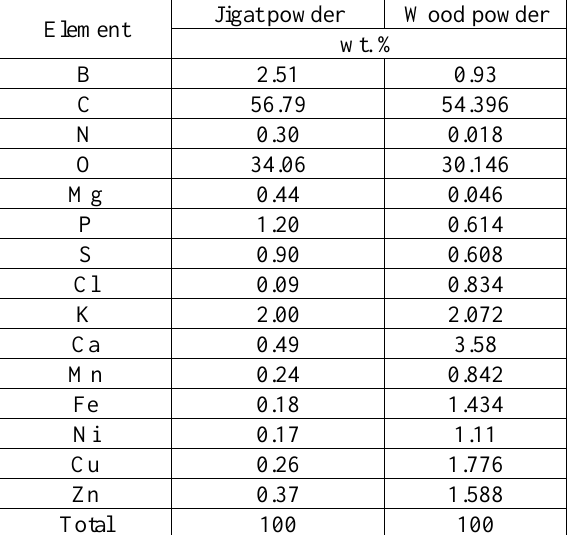
Table 6. Chemical composition of Jigat and wood powder (EDS